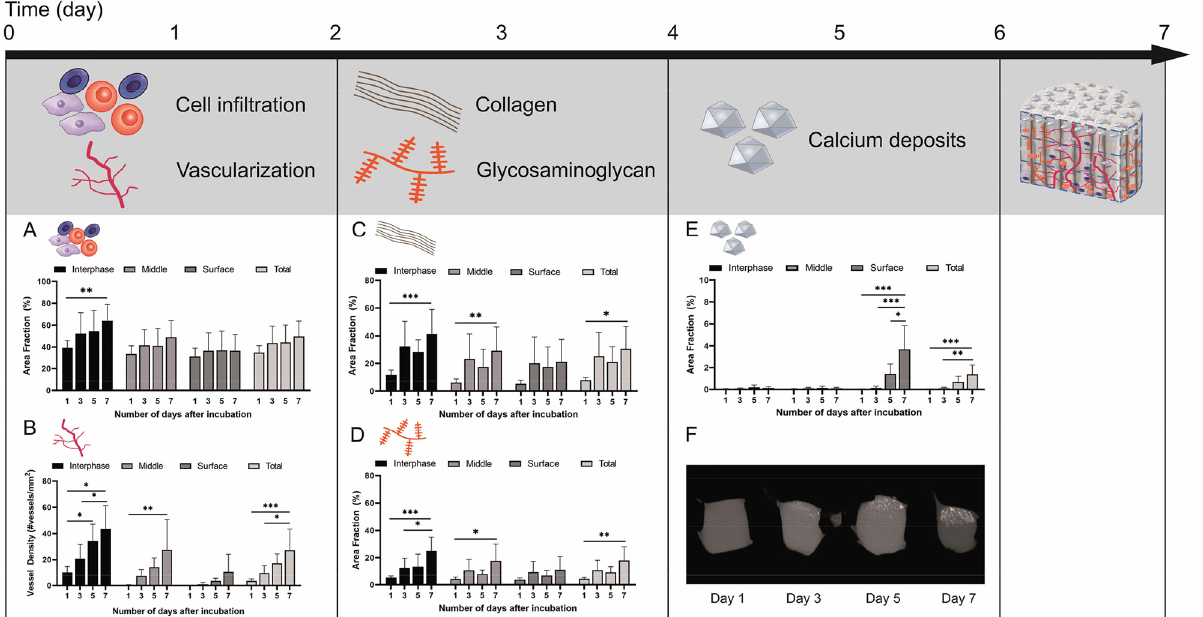
Figure 2. Time course regarding the occurrence and impact of key factors on the calcification process analyzed in collagen scaffold. The timing of the various factors involved was investigated ( A – F ) using the CAM assay. A marked increase in cell infiltration and vessel density in the scaffold was observed on day 1 ( A , B ). On day 3, there was a distinct increase in collagen and glycosaminoglycan (GAG) content ( C , D ) and from day 5 on, an accumulation of calcium deposits could be sufficiently detected ( E ), which could also be shown by microCT analysis ( F ). Schematic scaffold with the localization of key factors is shown after 7 days of incubation on the